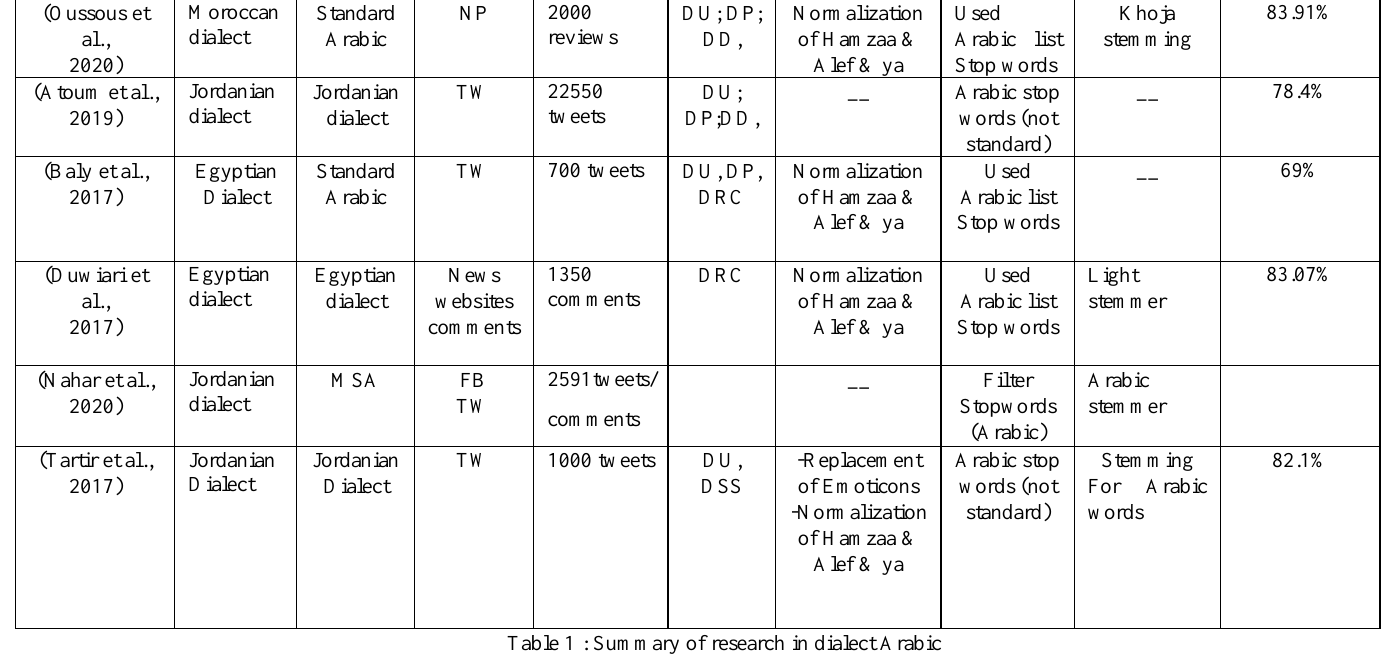
Table 1 : Summary of research in dialect